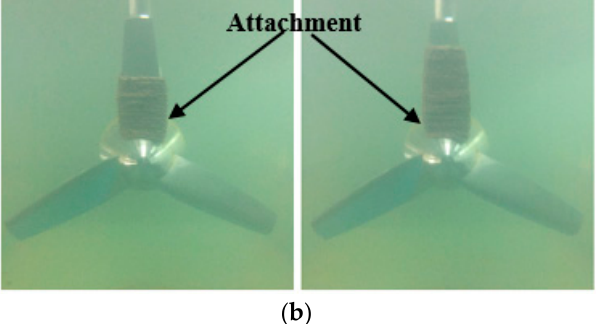
Figure 2. Image under different environments. ( a ) Waterborne image [17]; ( b ) Underwater image.